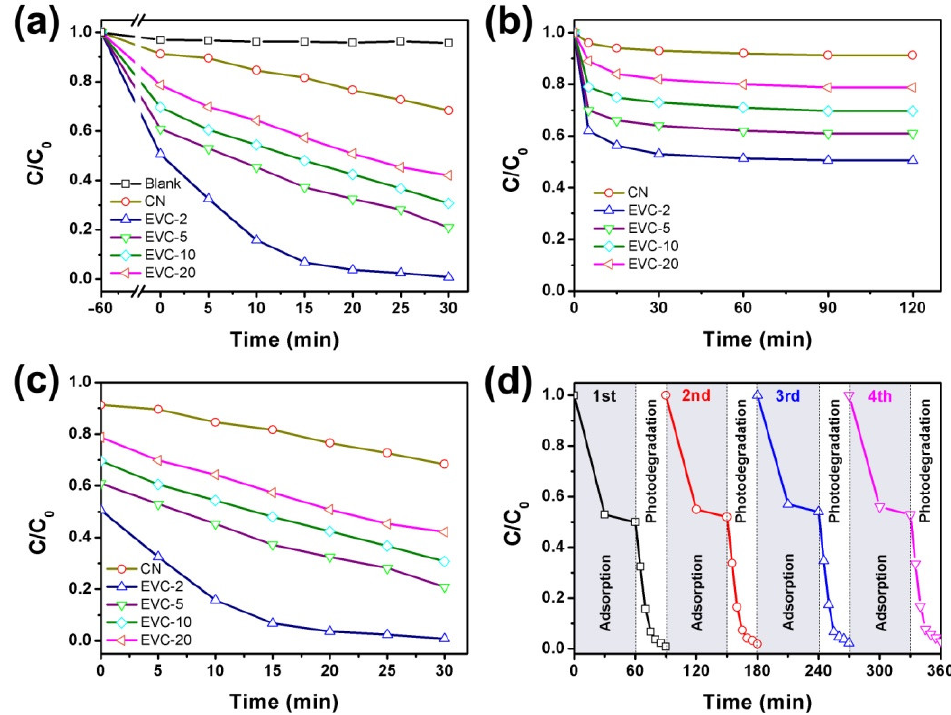
Figure 8. ( a ) The removal of MB over the as-prepared catalysts under visible light irradiation, ( b ) the adsorption of MB over the catalysts in the dark, ( c ) the photodegradation of MB over the cata- lysts under visible light irradiation, ( d ) the synergistic removal of MB over EVC-2 in the recycle